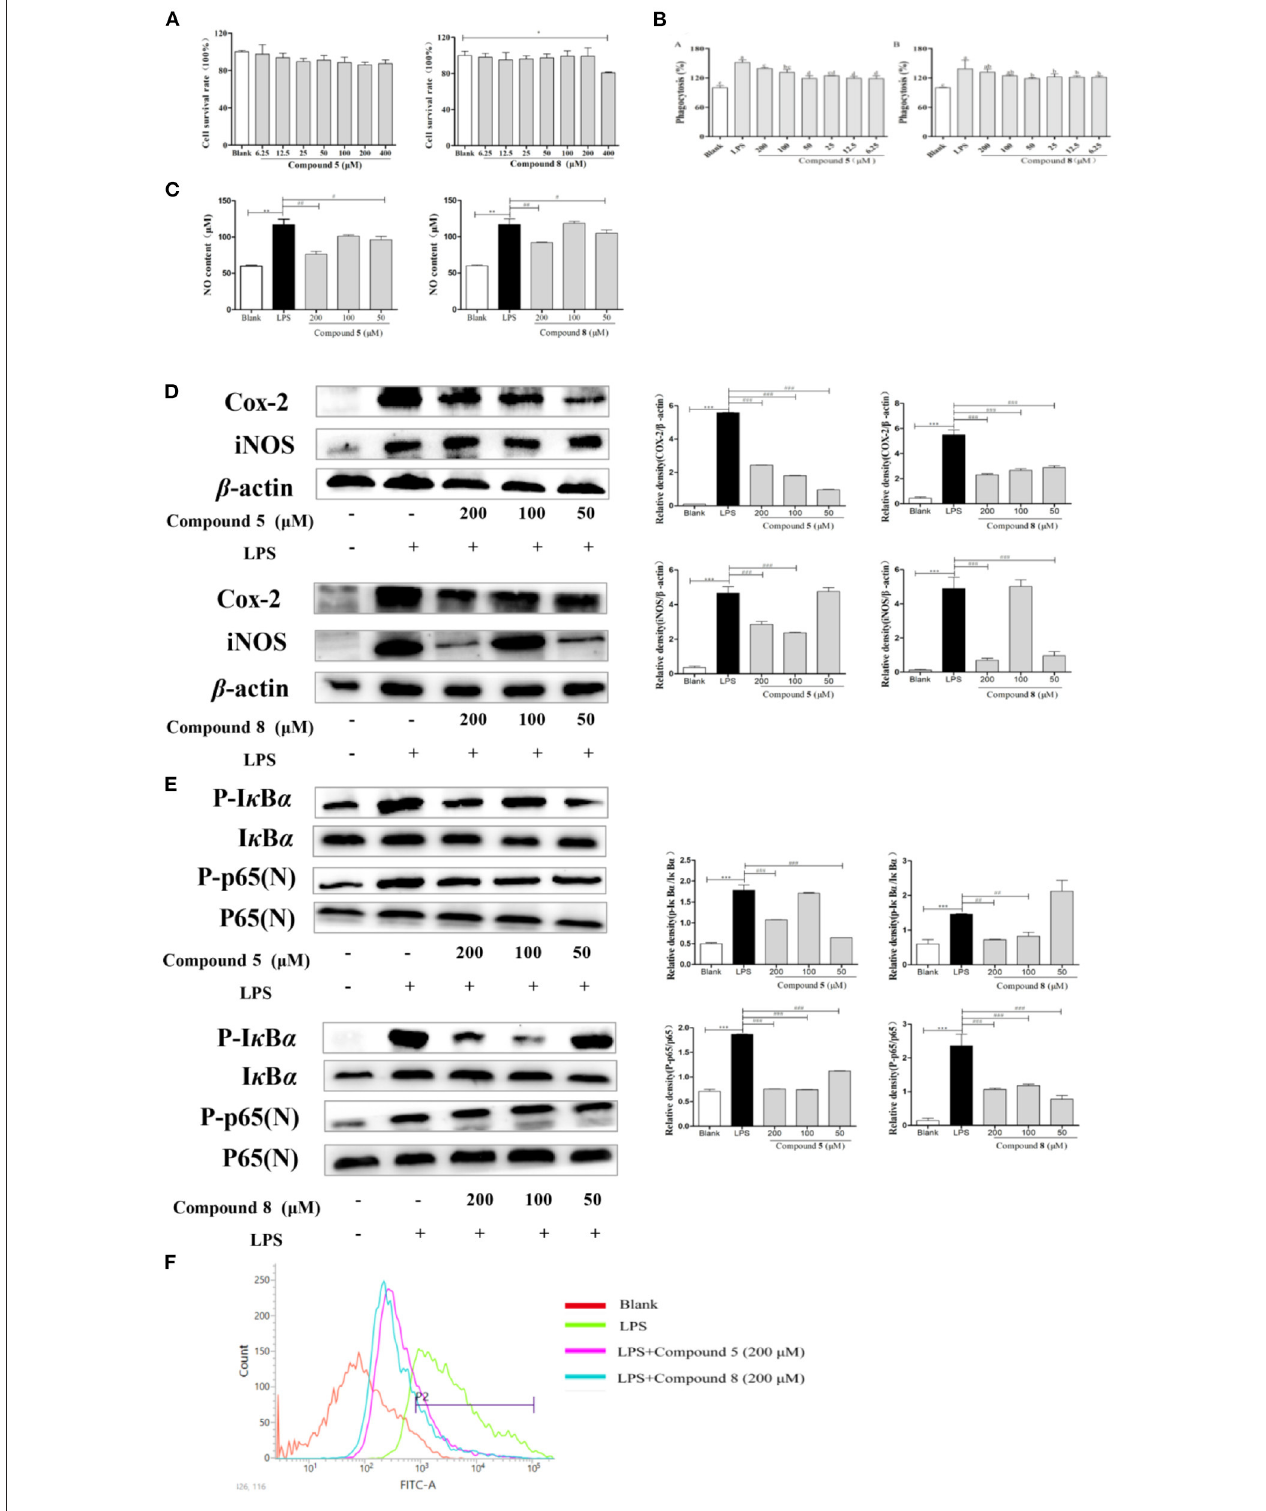
FIGURE 3 | Effects of compounds 5 and 8 on the nuclear factor- κ B (NF- κ B) pathways in lipopolysaccharide- (LPS) induced RAW264.7 Cells. (A) Cell survival rates. (B) Phagocytic activity of RAW264.7. (C) The expression levels of nitric oxide (NO) production. (D) mRNA and protein expression of cyclooxygenase- (COX) 2 and inducible nitric oxide synthase (iNOS). (E) Expression levels of key proteins in the NF- κ B pathways. (F) Production of reactive oxygen species (ROS). β -Actin served as a control. Data shown are means ± SEM. *** p < 0.001, ** p < 0.01, * p < 0.05. ### p < 0.001, ## p < 0.01, # p < 0.05.